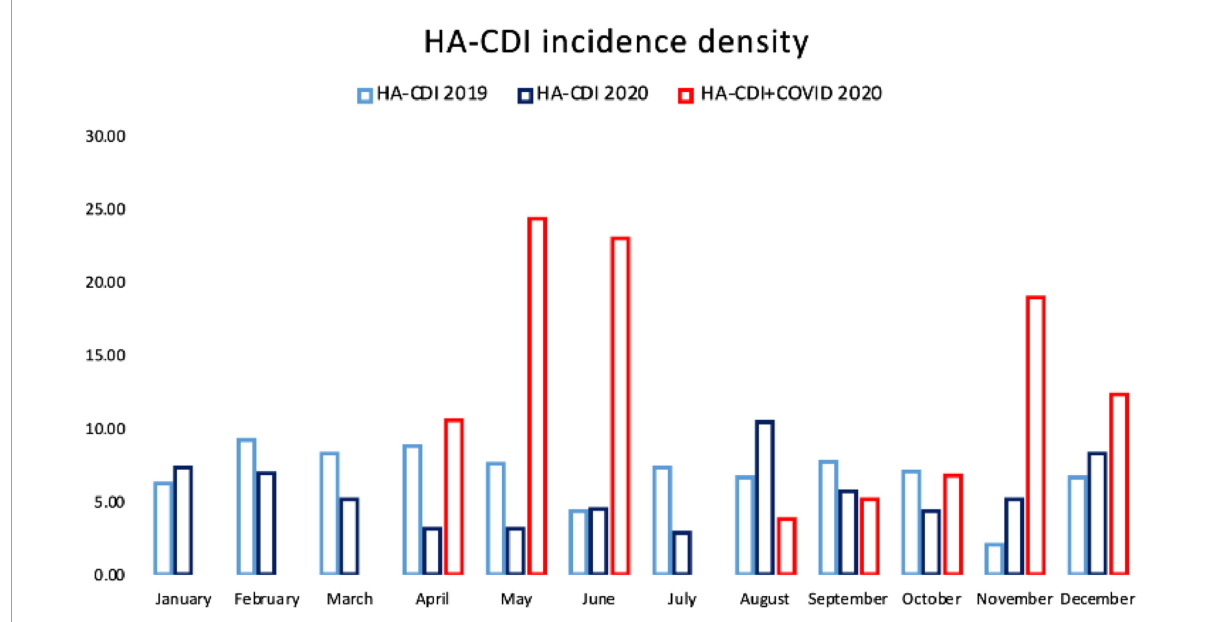
FIGURE1 HA-CDI incidence in 2019, in 2020 in non-COVID-19 patients and in 2020 in COVID-19 patients.